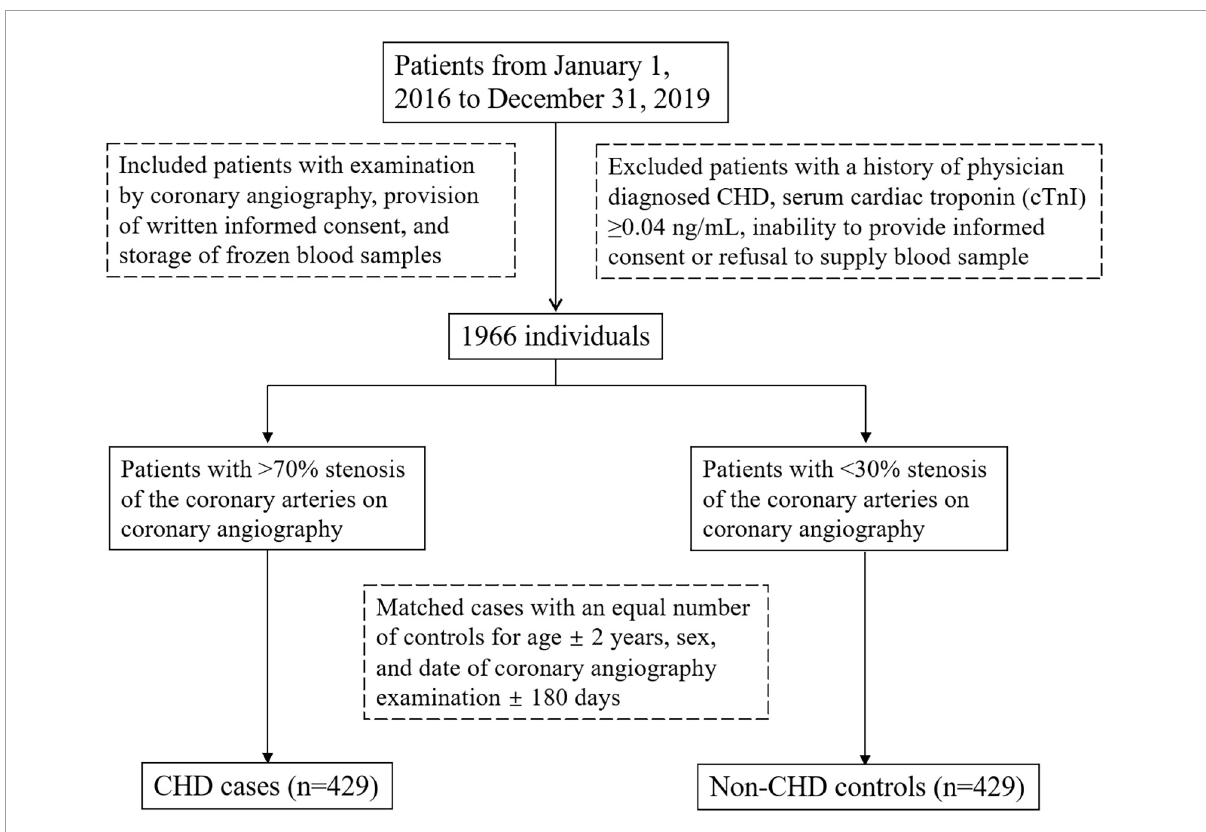
FIGURE1 The flow chat of the enrollment.